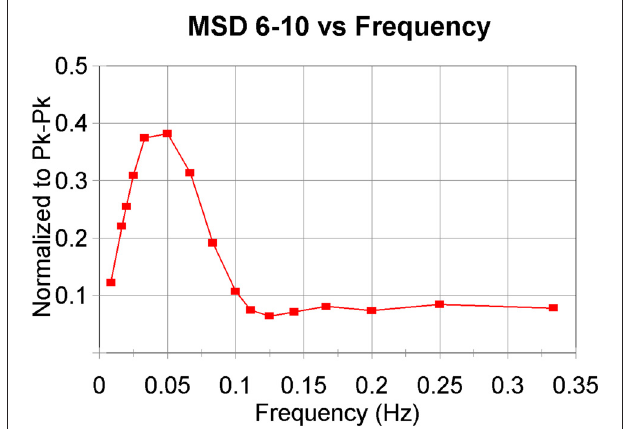
FIGURE 3 | Band-pass filter characteristics of MSD 6 − 10 . The algorithm has been applied to model-generatedbeat-series with additional noise. A simplified model of baroreflex control has been used as in deBoer et al., 1987 to generate the intervals. Average heart period around 1000ms. A modulating “respiratory” frequency was forced with periods from 3 to 120s. The values for MDS 6 − 10 have been normalized to the peak–peak amplitudes of the forced oscillations (Berntson et al.,